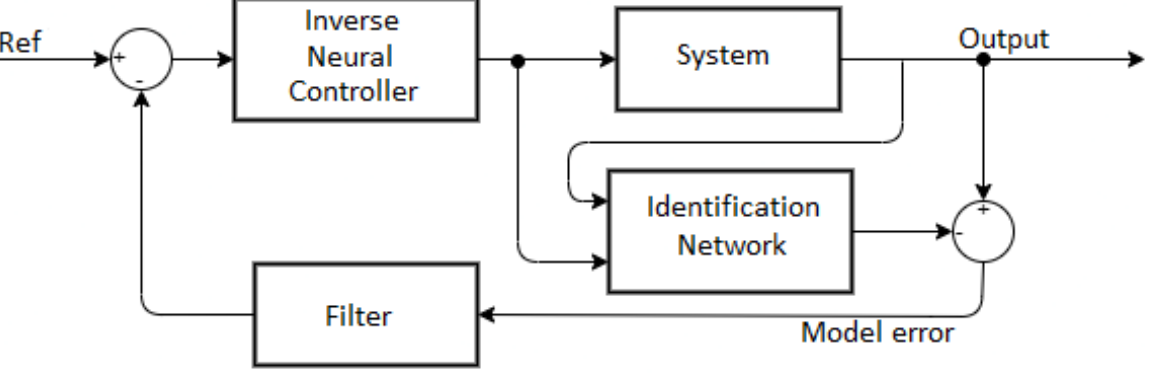
Figure 20. Diagram of the internal model